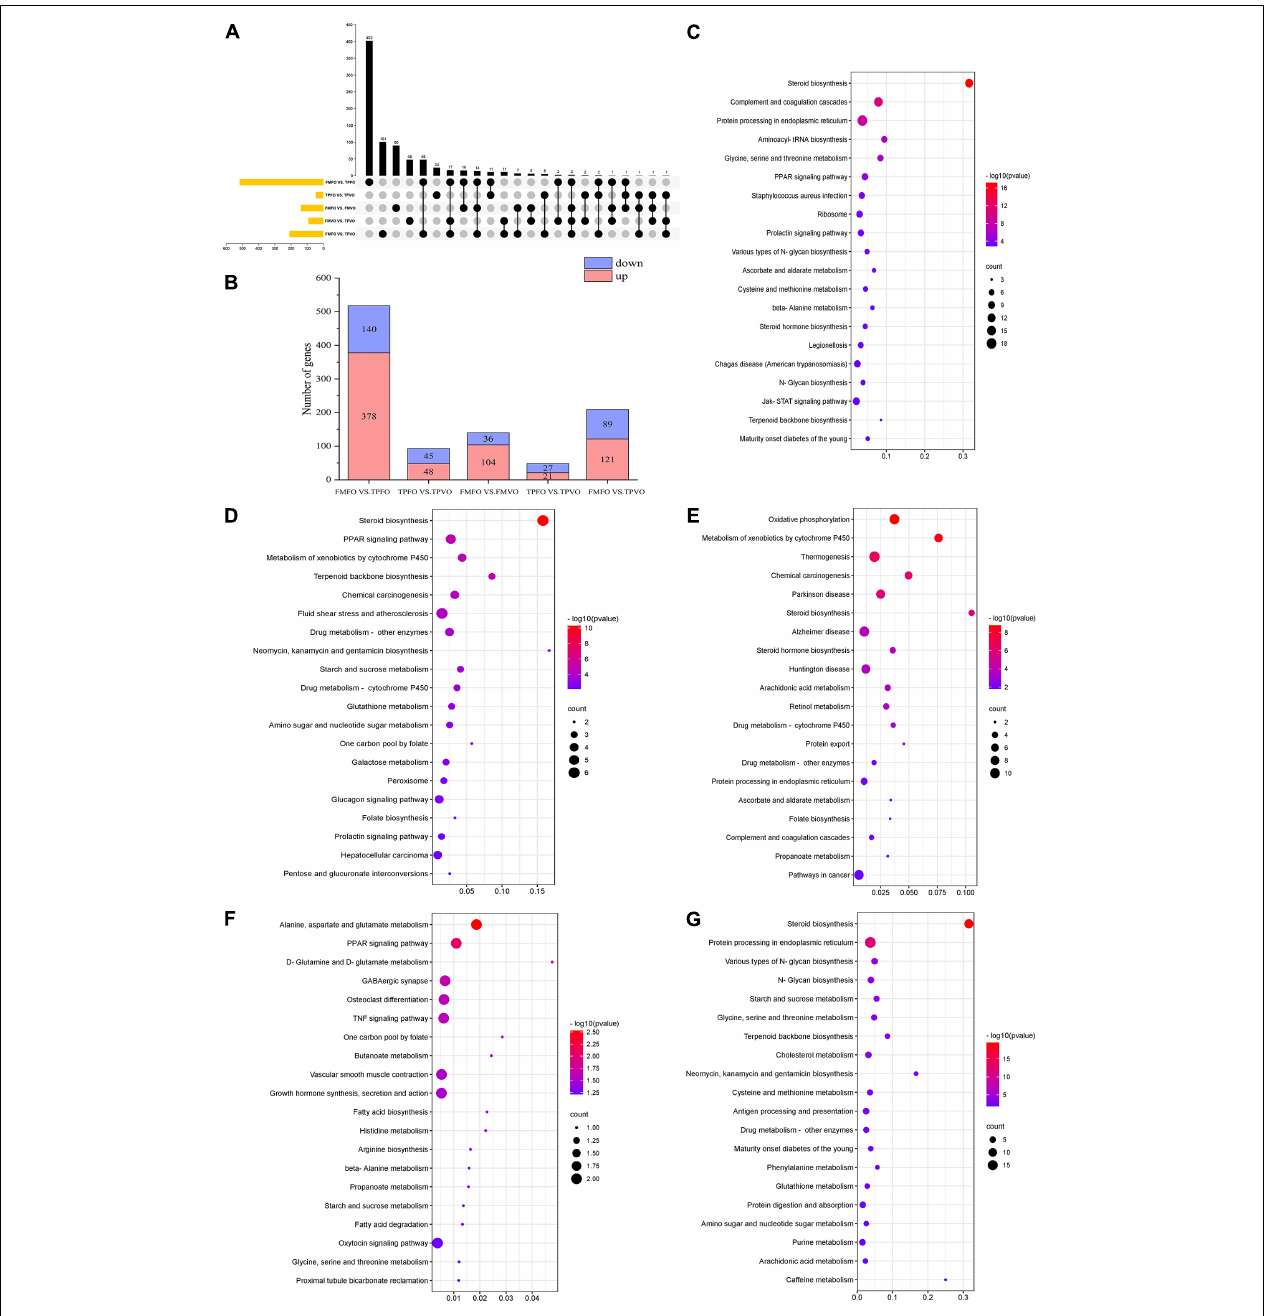
FIGURE 1 | Transcriptomic analysis of O. mykiss fed diets with replacement of FM and/or FO. The number of up- and down-regulated DEGs were identified in the FM replacement and FO replacement (A,B) . KEGG pathways analysis of DEGs in response to FM replacement (C,D) , FO replacement (E,F) , and combined replacement of FM and FO (G) . Pathway enrichment analysis plots (top 20) of upregulated expressed metabolisms according to P < 0.05.